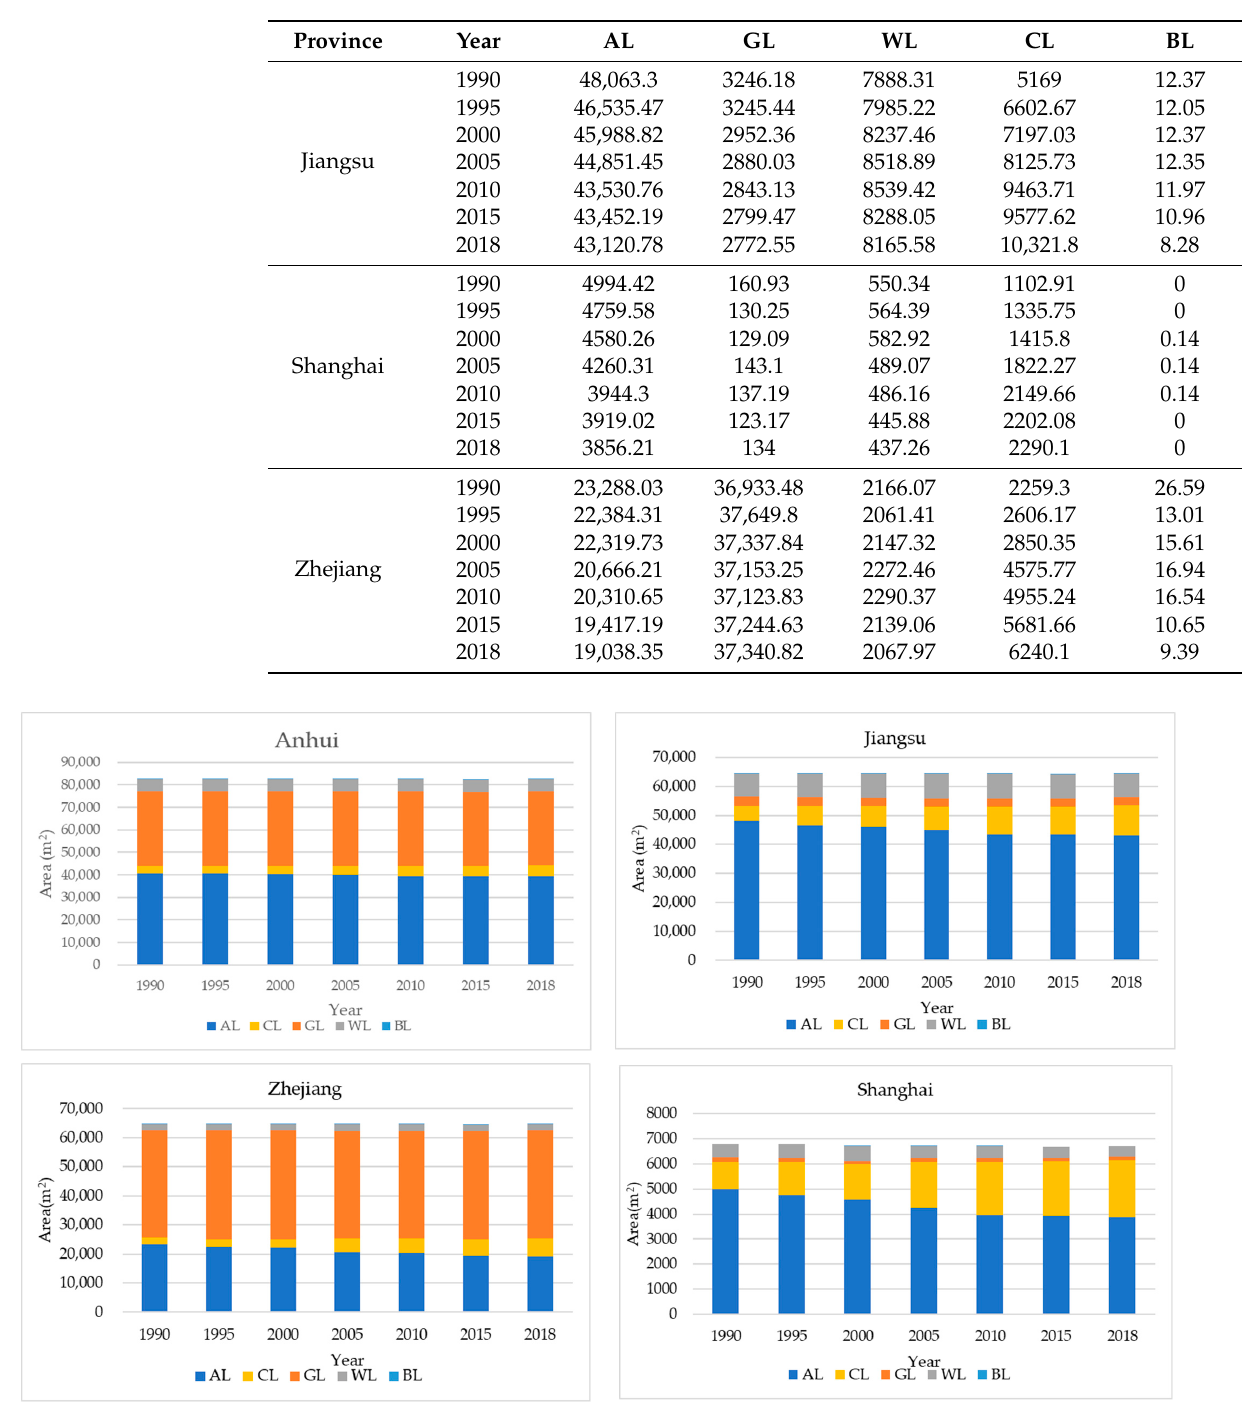
Figure 4. Visualization of the LUC change in different provinces.